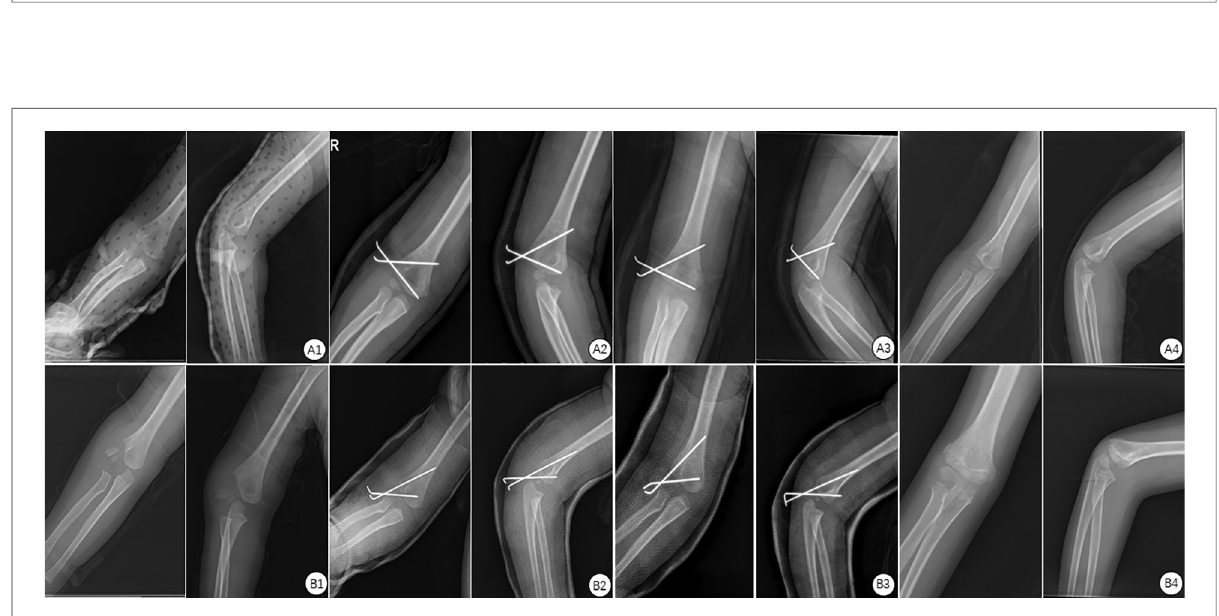
FIGURE 3 ( A1 ) Ultrasonography on the transverse plane showed that the cartilage hinge (white arrow) was broken (blue arrow), the “ step sign ” was seen at the broken end, and the triangular bone fragment (yellow arrow) at the broken end was free from the cartilage articular surface. (Note: L the humerus Lateral condyle; M: the medial condyle of the humerus). ( A2 ) Ultrasonography on the transverse plane showed that the cartilage hinge (white arrow) was broken (blue arrow), and the “ step sign ” was seen at the broken end. ( A3 ) Ultrasonography on the coronal plane showed that the cartilage hinge (white arrow) was broken (blue arrow), and the “ step sign ” was seen at the broken end. (Note: R : radial head; H: humeral shaft). ( A4 ) Ultrasonography on the coronal plane shows the continuity of the cartilage hinge (white arrow). (Note: it radial head; humeral shaft).